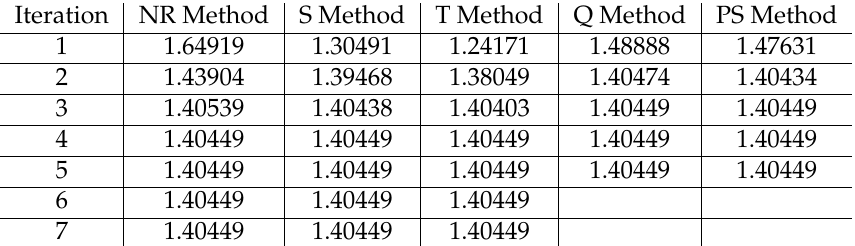
Table 1. Numerical results for the Equation (18)